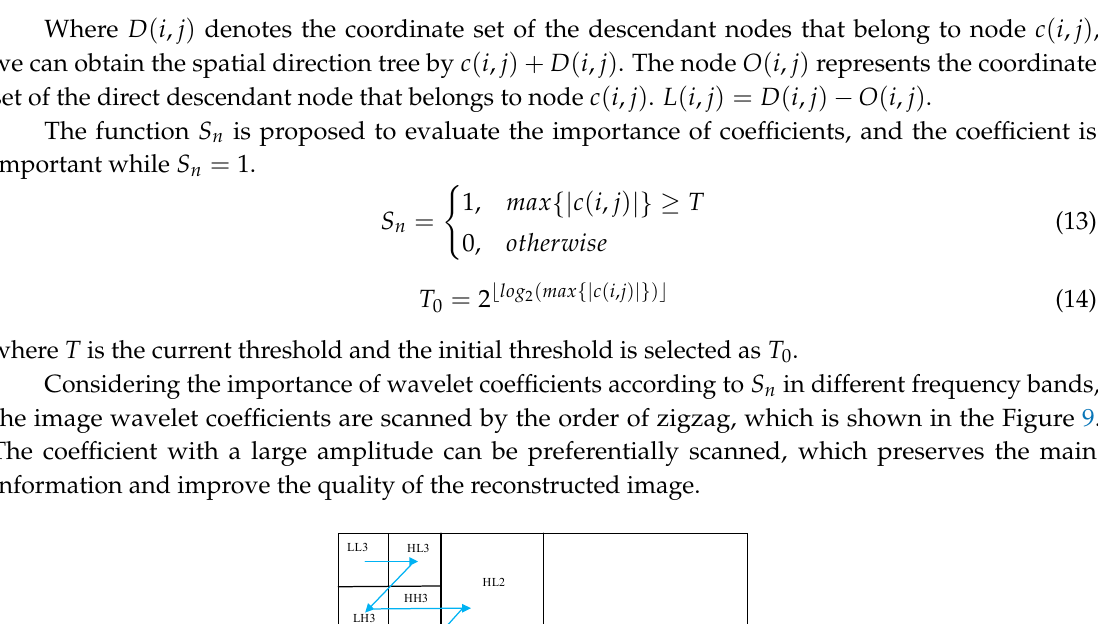
Figure 8. Three-level wavelet direction tree partition set.